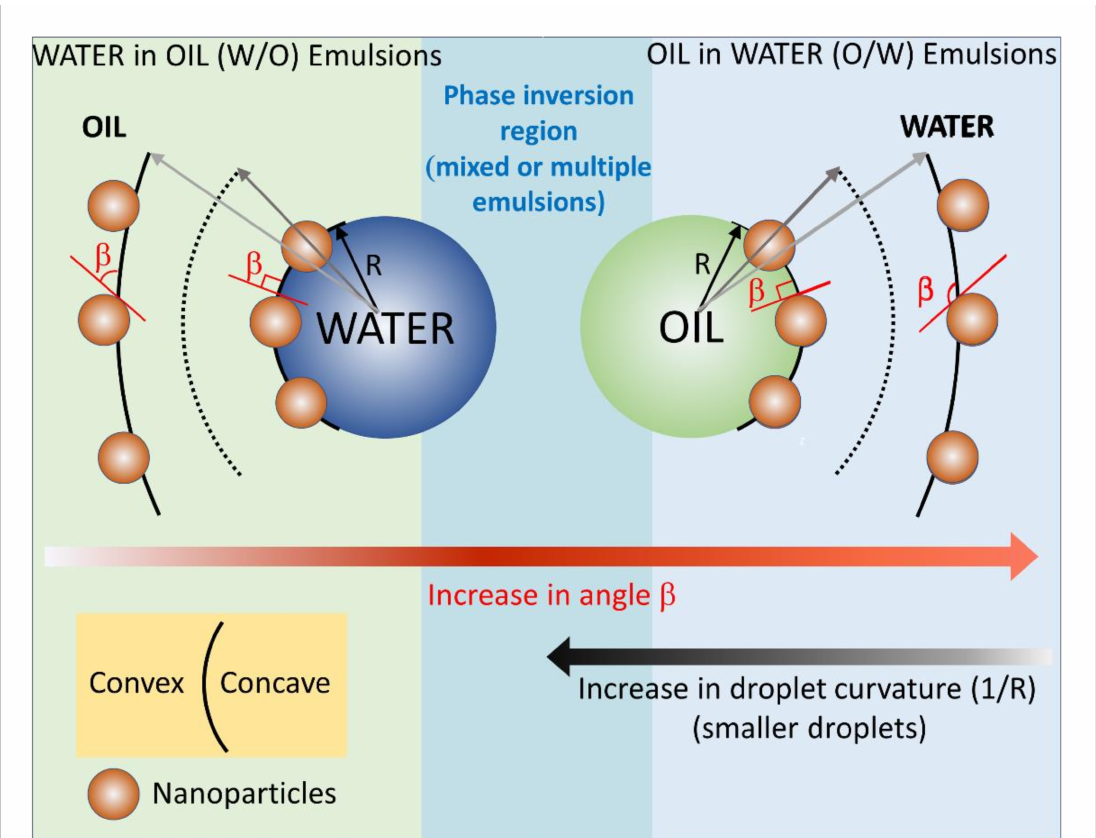
Figure 6. Diagram depicting the relationship between the contact angle β of the NP with the oil, i.e., immersion depth of the nanoparticle at the oil/water interface and the curvature of the interface. For o / w emulsions, β > 90 ◦ , the larger the value of the contact angle β , the larger the emulsion droplets. For w / o emulsions, β < 90 ◦ , the smaller the value of the contact angle β , the larger the emulsion